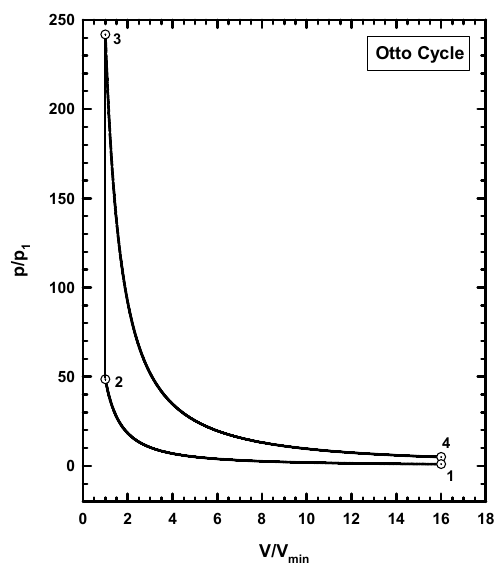
Figure 25. The cylinder pressure (relative to the initial pressure) as a function of the cylinder volume (relative to the minimum volume) for the Otto cycle.